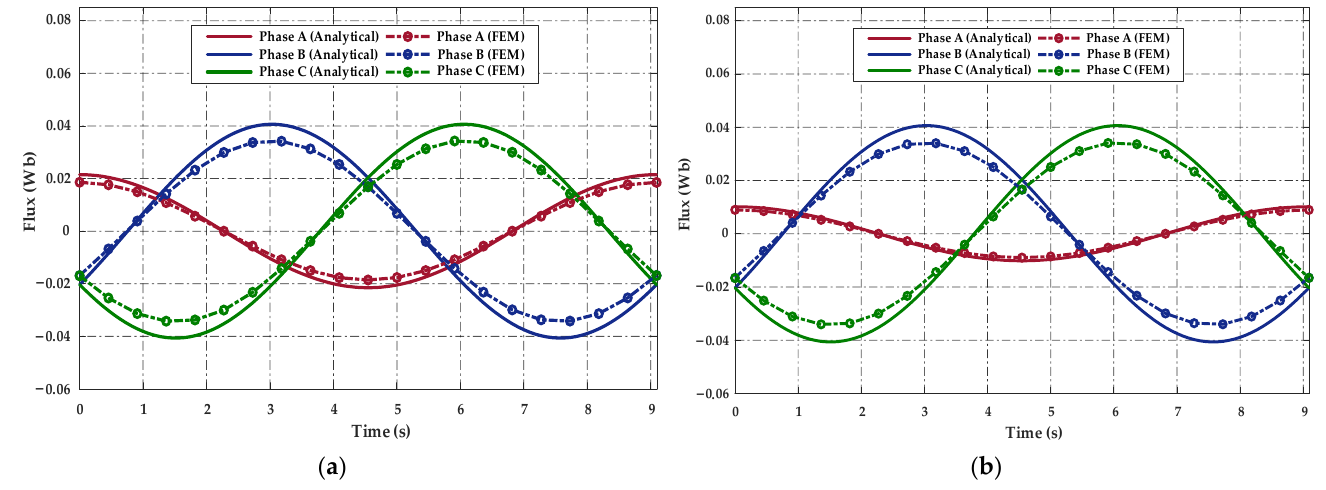
Figure 11. Total flux created by the stator winding, ( a ) Total flux with 25% of LTs fault; ( b ) total flux with 50% of LTs fault.